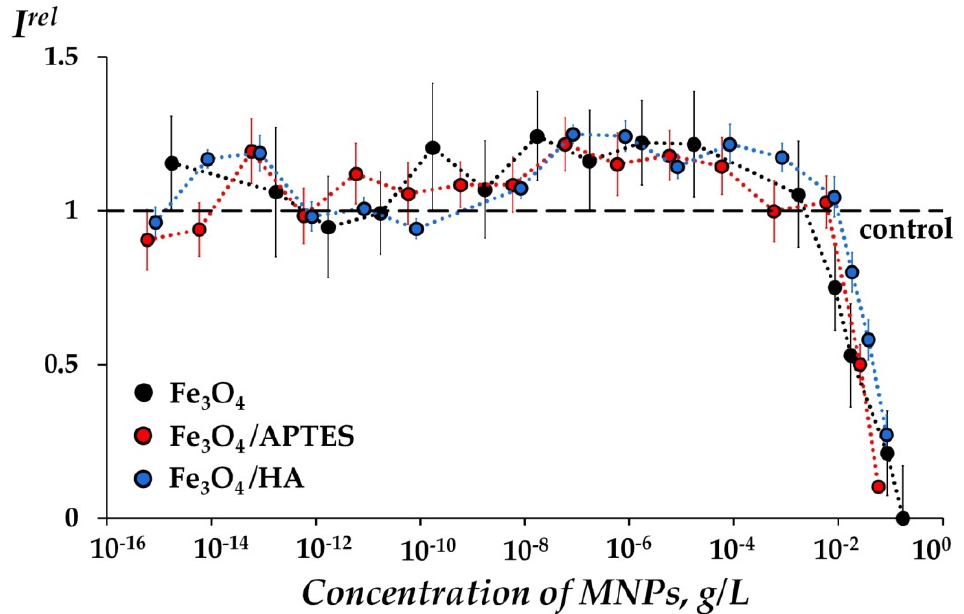
Figure 3. Relative bioluminescence intensity, I re l , in bacterial suspension vs. MNP concentration, g/L. Bare Fe 3 O 4 –black circles, Fe 3 O 4 /APTES–red circles, and Fe 3 O 4 /HA–blue circles. Table 2. Effective concentrations of MNPs, EC 50 (i.e., concentrations inhibiting bioluminescence intensity by